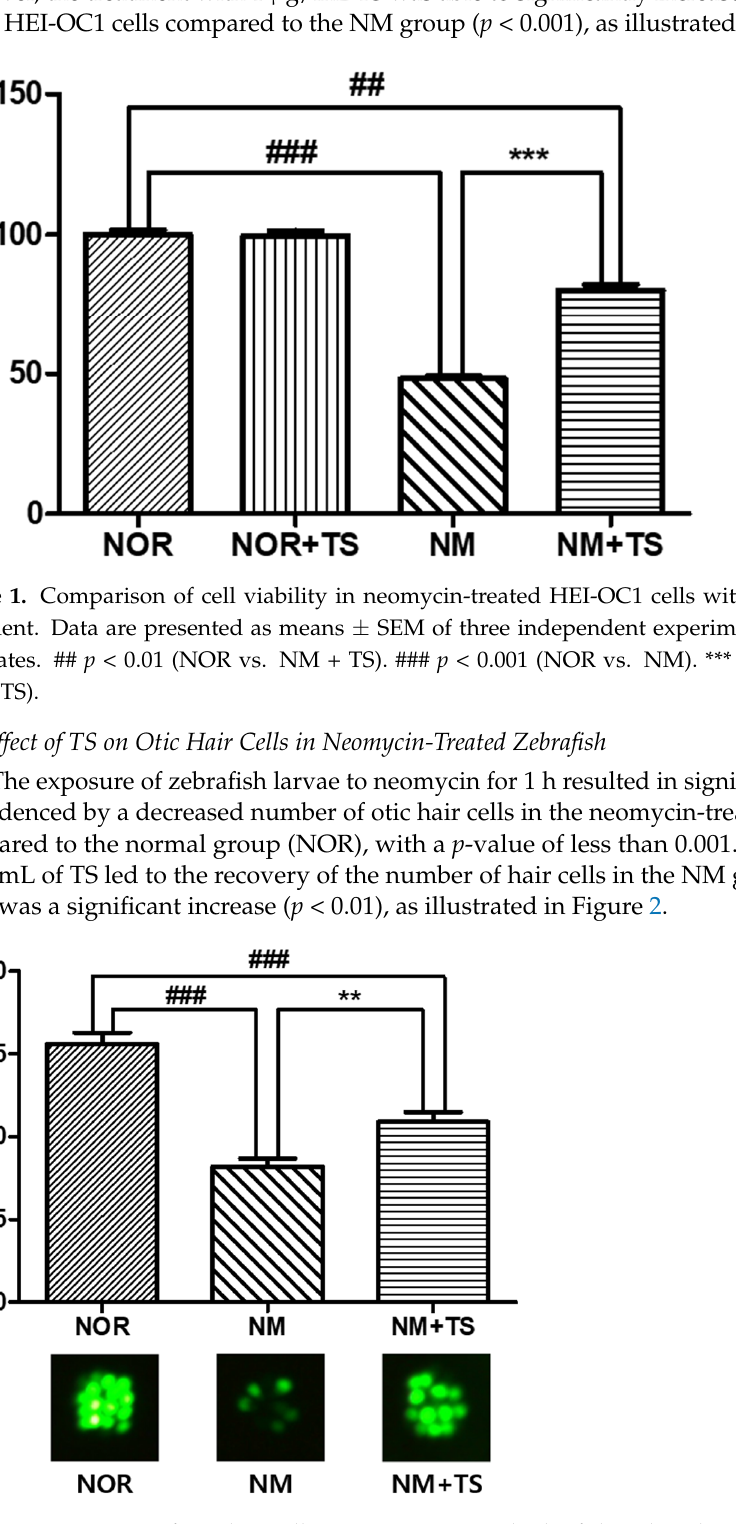
Figure 2. Comparison of Otic hair cells in neomycin-treated zebrafish with and without TS treatment. Data are presented as means ± SEM. ### p < 0.001 (NOR vs. NM and NOR vs. NM + TS). ** p < 0.01 (NM vs. NM + TS). N = 10 per group.